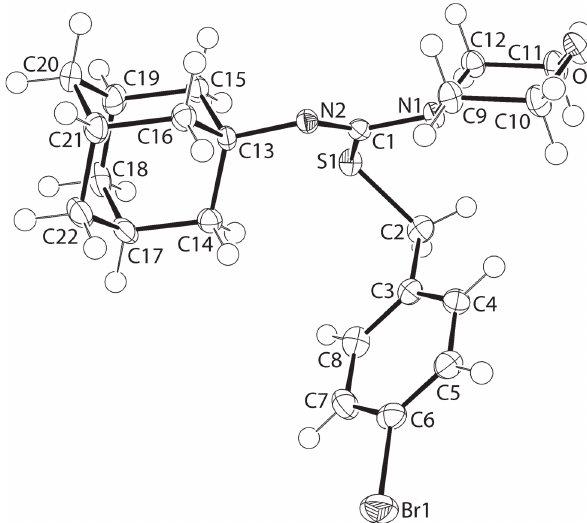
Table 1: Data collection and